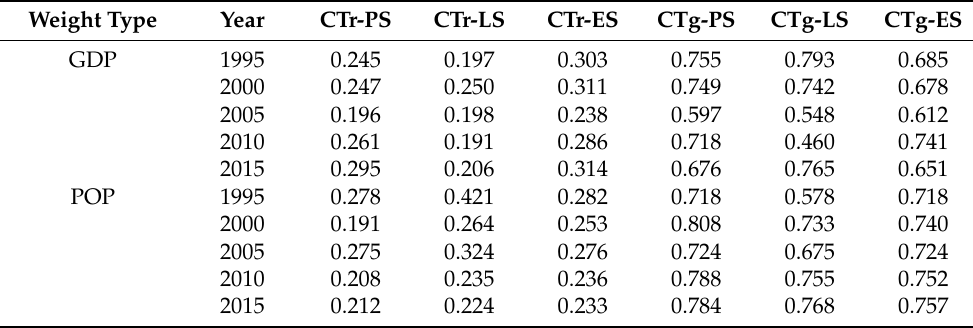
Table 6. Contribution rate of the PLES-related Theil index of the two types of cities, 1995–2015. Weight Type